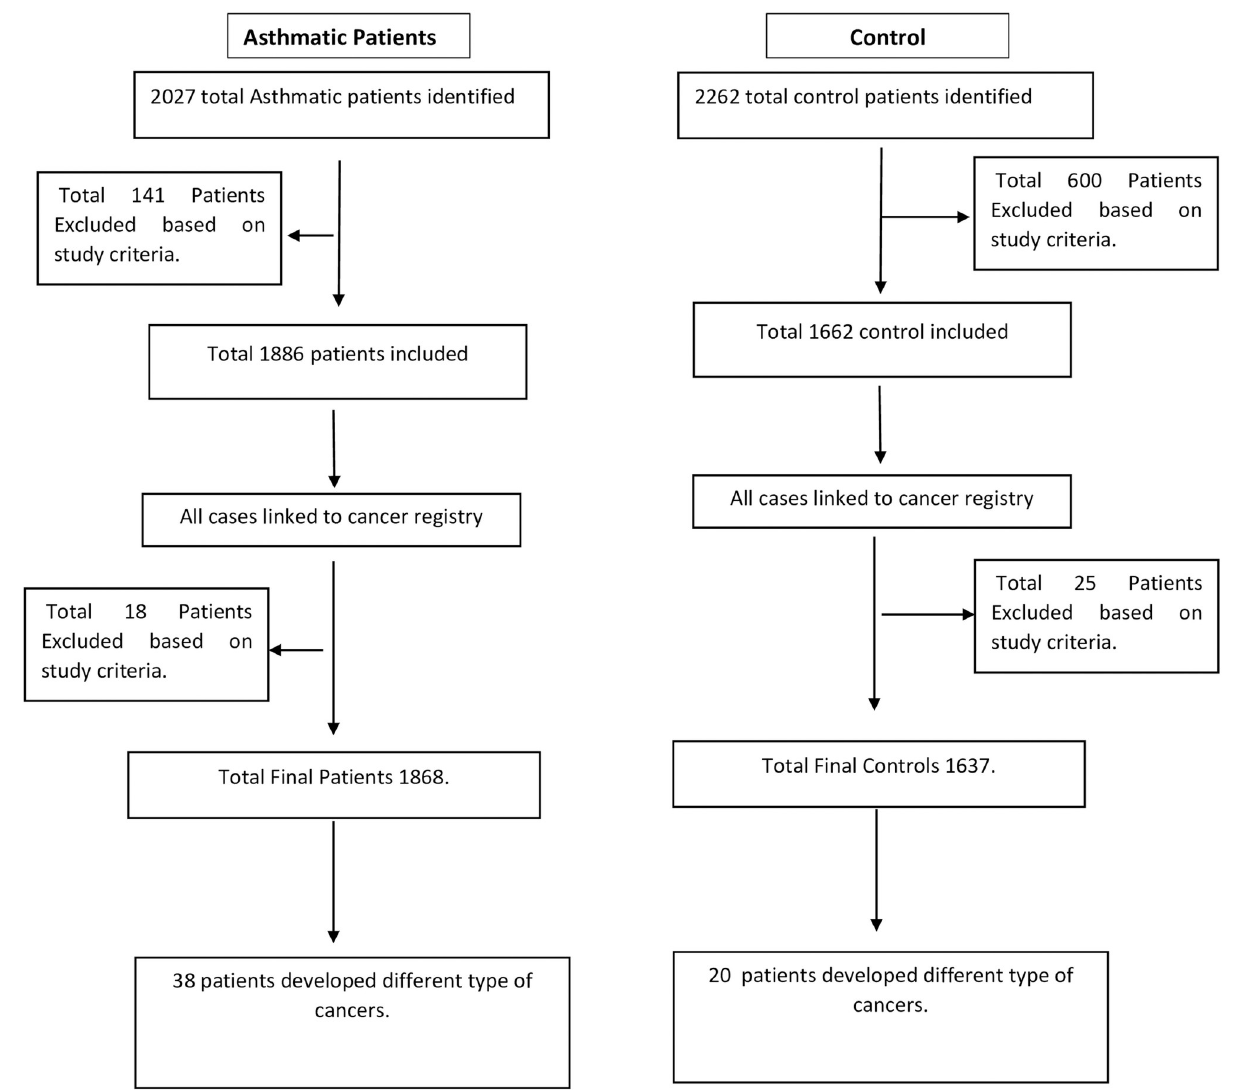
Fig 1. The flow chart of the study